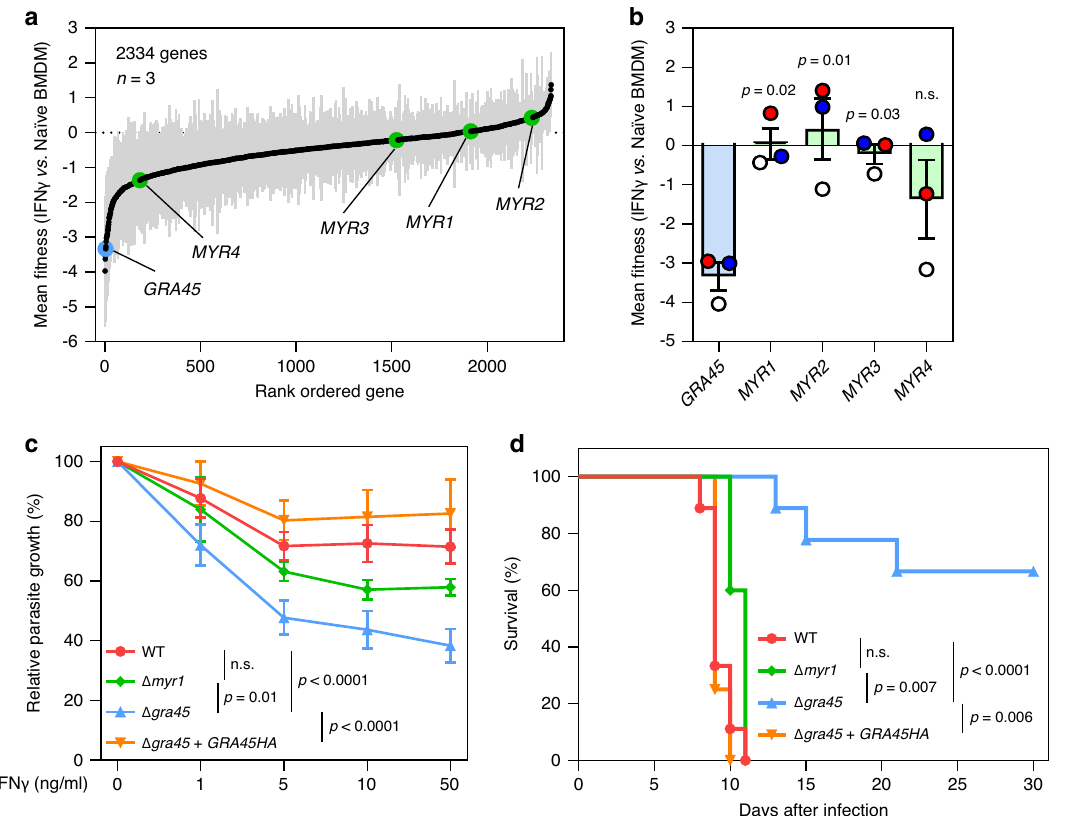
Fig. 6 Compared to Δ myr1 parasites, Δ gra45 parasites are more susceptible to IFN γ and less virulent in mice. a Toxoplasma genes that have at least four sgRNAs present after the 3rd passage in naïve BMDM in the three independent screens are rank-ordered according to their IFN γ vs. Naïve BMDM fi tness scores. Data are displayed as average fi tness scores (black plots) ± SEM (gray lines). b Mean IFN γ vs. Naïve BMDM fi tness of GRA45 , MYR1 , MYR2 , MYR3 , and MYR4 . Data are displayed as mean ± SEM with independent screens ( n = 3) indicated by the same color dots (S1: white; S2: blue; S3: red). The signi fi cant difference was analyzed with one-way ANOVA with Tukey ’ s multiple comparisons test. c Murine BMDMs prestimulated with or without IFN γ